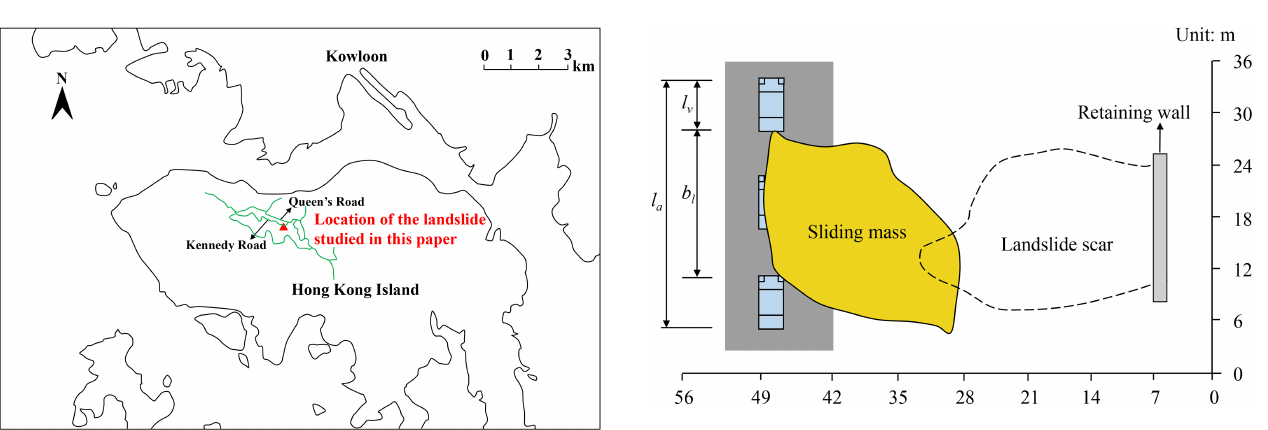
Figure 3. Plan view of the landslide studied in this paper. Table 1. Percentage contribution of the vehicle type to the total number of vehicles, and the length and passenger capacity of dif- ferent vehicle types in Hong